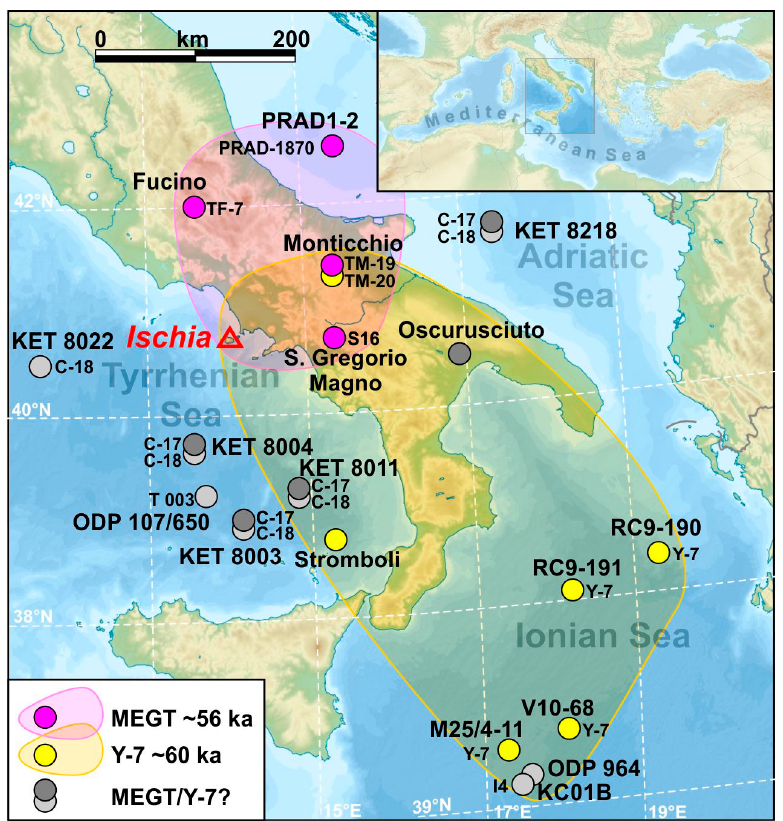
Figure 8. Occurrence of the Monte Epomeo Green Tuff distal tephra, the marine Ischia tephra Y-7, and other “Ischia layers” corresponding to either MEGT or Y-7 or both tephra layers, but still not definitively correlated. Data sources: PRAD 1-2 [20]; Fucino [2]; Lago Grande di Monticchio [6]; San Gregorio Magno [7,8]; Oscurusciuto [10]; KET 8004, KET 8011, KET 8003, KET 8218 [3]; ODP Leg